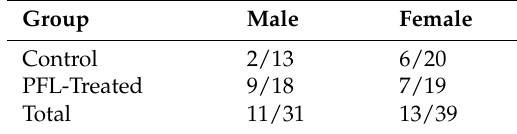
Table 3. Number of transmission events/exposed deer mice in male and female